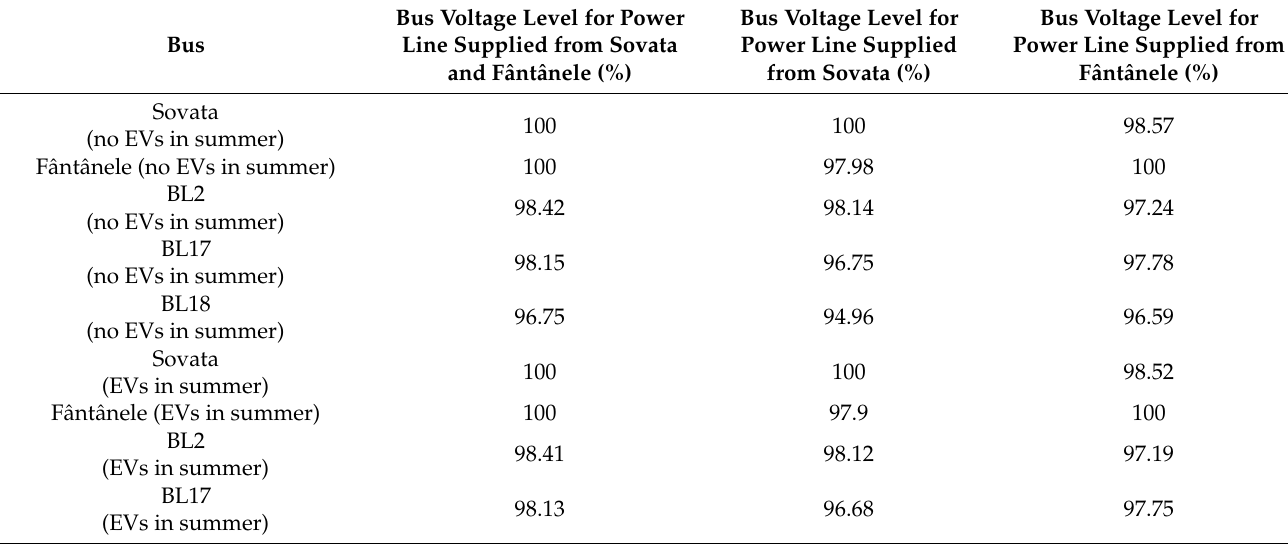
Table 19. Voltage level at 10:00 (scenario